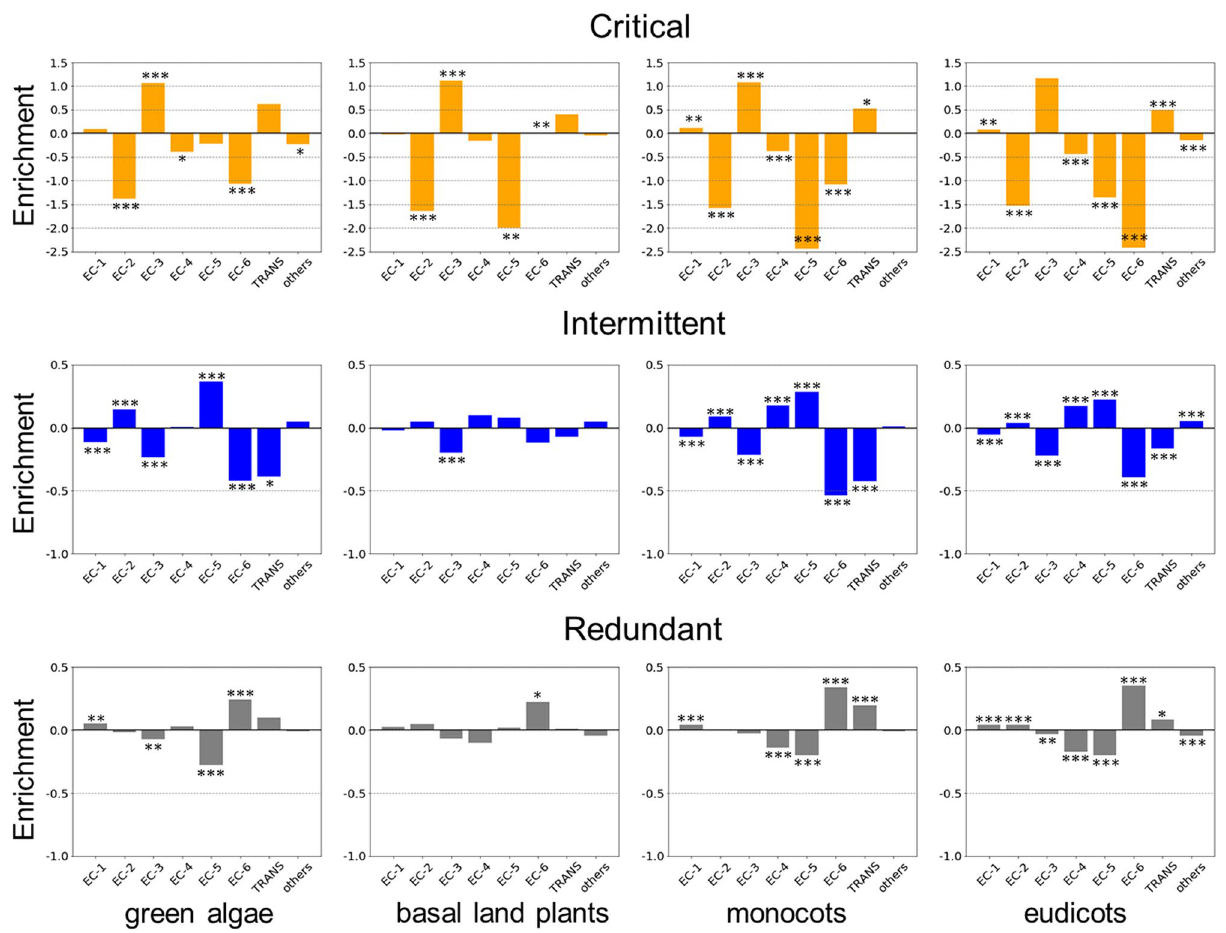
Figure 6. Enrichment or depletion of driven enzymes associated with each control category and classified into EC classes. The fraction of enzymes in each control category and EC class is normalized for each control category. This fraction captures the abundance of enzymes for each EC class in each control category. The results are shown for each plant lineage. The statistical significance of the enrichment or depletion of the identified critical, intermittent and redundant driven enzymes in each EC class is evaluated using fisher’s exact test. The two-tailed exact p-values are denoted in each bar using the following notation: * p ≤ 0.05 , ** p ≤ 0.01 , *** p ≤ 0.001 . A detailed list of the exact p-values is shown in Table